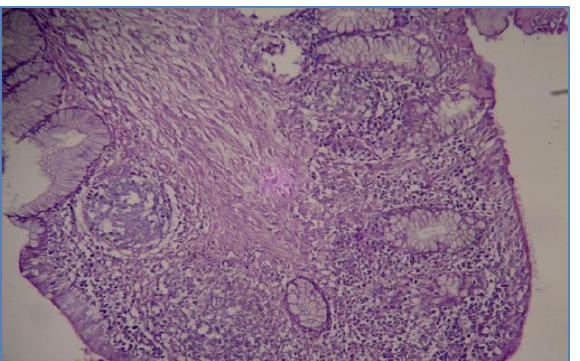
Figure, 4: Control larynx shows normal tissue, 72 hrs. post infection (H and E) (100X).